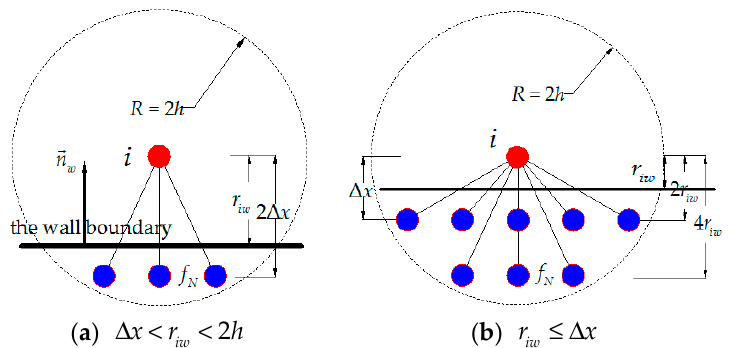
Figure 1. Fictitious particles generation mechanism of the local mirror image method for a fluid particle near the wall boundary.